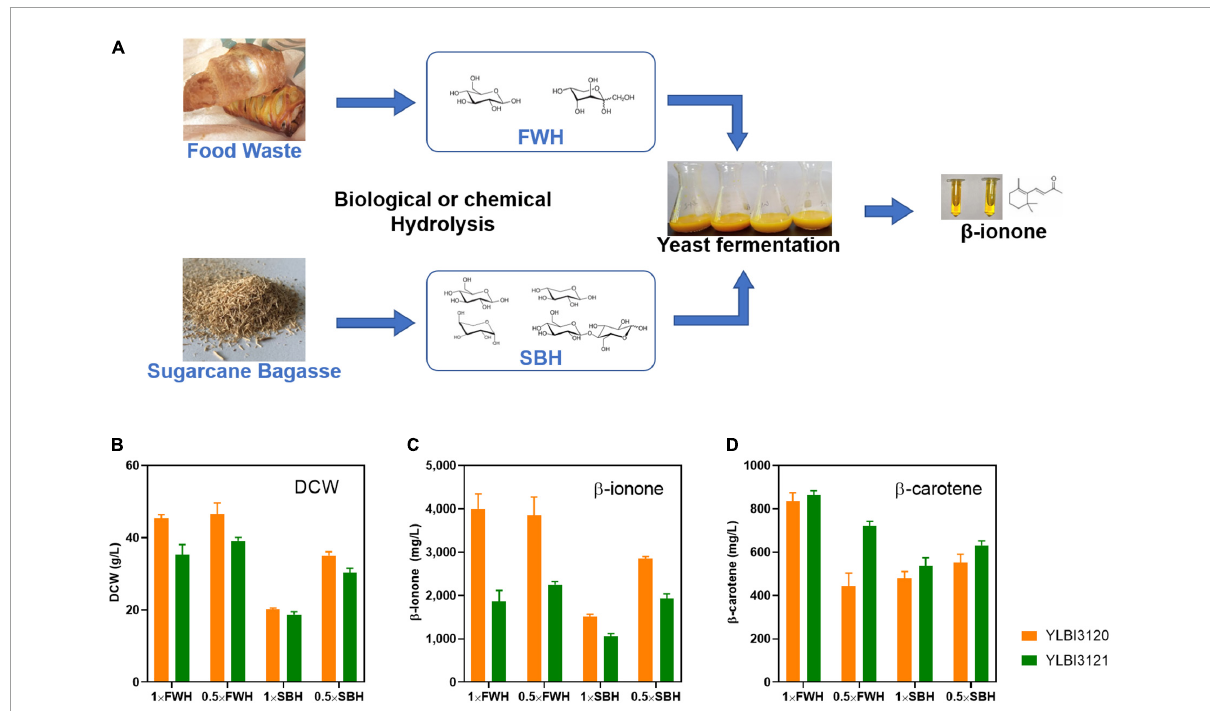
FIGURE2 High-yield production of β -ionone from food waste and sugarcane bagasse utilizing an integrated process. (A) The integrated process involved two steps. First, the food waste or sugarcane bagasse was converted into simple sugar hydrolysates via biological or chemical hydrolysis. These hydrolysates were then fermented with engineered yeast cells to produce β -ionone. Plot shows (B) the dry cell weight (DCW), (C) the β -ionone concentration, and (D) the β -carotene concentration. FWH, food waste hydrolysate; SBH, sugarcane bagasse hydrolysate. Fermentation was conducted with 25 mL of hydrolysate medium containing 10% (v/v) dodecane, and the cultures were incubated with shaking at 250 rpm at 20 ◦ C for 12 days. Experiments were performed in